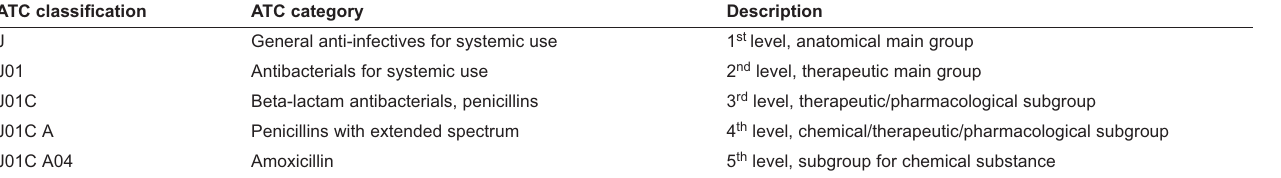
TABLE 1 Classification of amoxicillin of the Anatomical Therapeutic Chemical (ATC) classification system